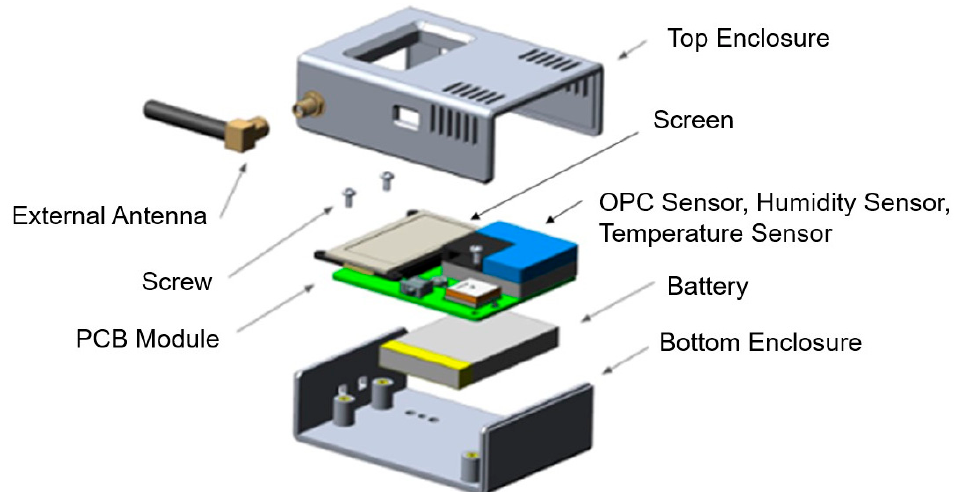
Figure 2. Exploded view of the AeroSpec hardware unit, which consists of environmental sensors, the PCB board, LiPo battery, and screen. The electronics were assembled in an ABS plastic enclosure manufactured by Tool Less Plastics. The device dimensions are (H) 100 mm x (W) 60 mm x (D) 25 mm and weighs 120 g.